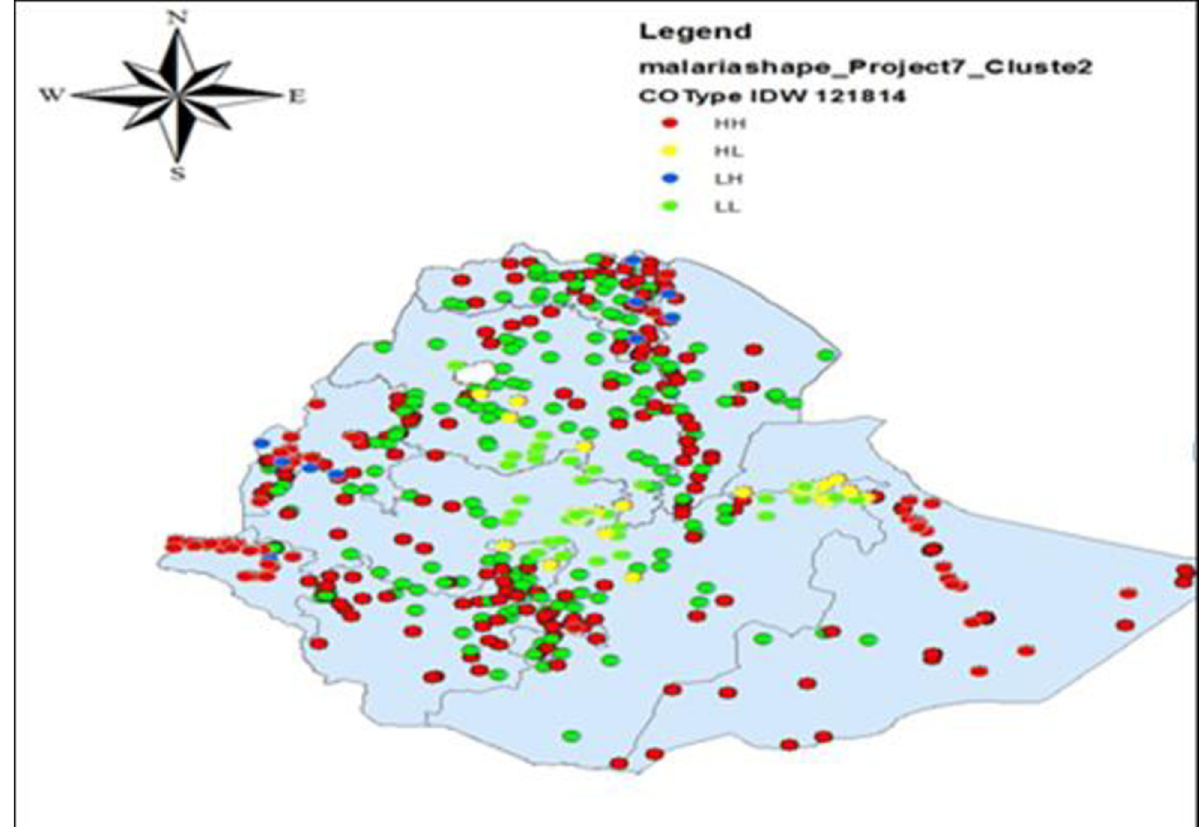
Fig 3. Spatial clustering of malaria in Ethiopia based on the Local Moran’s I statistic, from EMIS 2015.